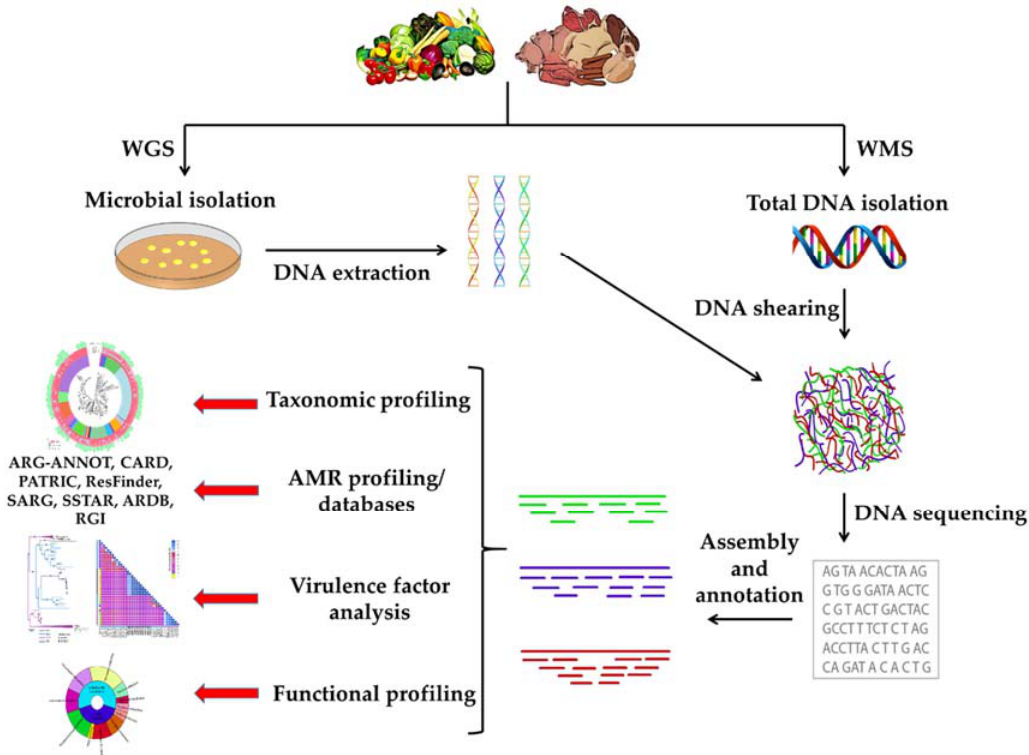
Figure 2. Schematic workflow of the approaches that may be followed when implementing WGS or WMS methodologies for AMR surveillance in foods. ARG-ANNOT: Antibiotic Resistance gene-ANNOTation; CARD: Comprehensive Antibiotic Resistance Database; PATRIC: Pathosystems Resource Integration Center; ResFinder: Antimicrobial resistance genes and/or chromosomal mutations database; SARG: Structured Antibiotic Resistance Genes Reference Database; SSTAR: Sequence Search Tool for Antimicrobial Resistance; ARDB: Antibiotic Resistance Genes Database; and RGI: Resistance Gene Identifier, respectively.